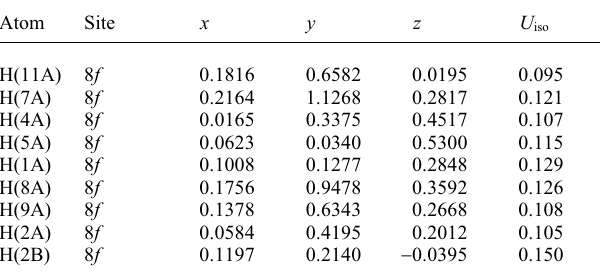
Table 2. Atomic coordinates and displacement parameters (in Å 2 )